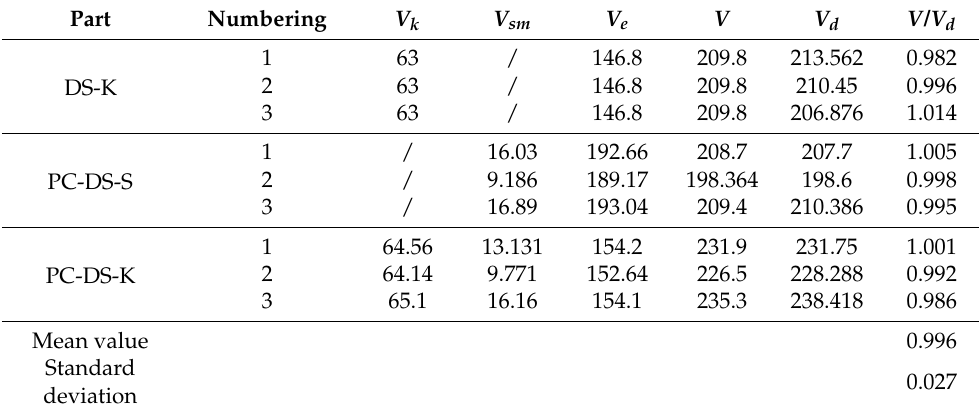
Table 5. Comparison of Formula and Experimental Results.